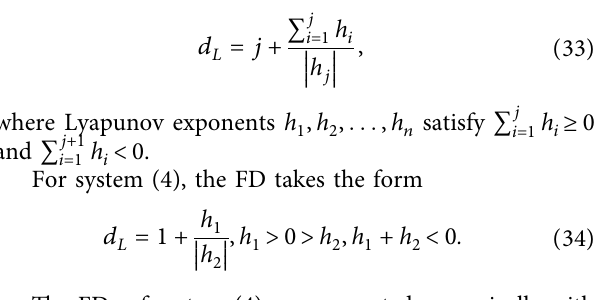
, h , . . . , h 􏽐 j h where Lyapunov exponents h n satisfy i ≥ 0 i � 1 1 2 h and 􏽐 j + 1 i < 0. i � 1 the System (4). To quantify the irregular behavior of system (4), the numerical diagnostics, power spectral density, and recurrence plot [41] are also generated. PSD, which depicts how a signal’s strength varies with frequency. A recurrence plot (RP) in chaos theory is a graph that displays the iter- ations during which phase space trajectories reach nearly the same region of the phase space for a given instant in time.